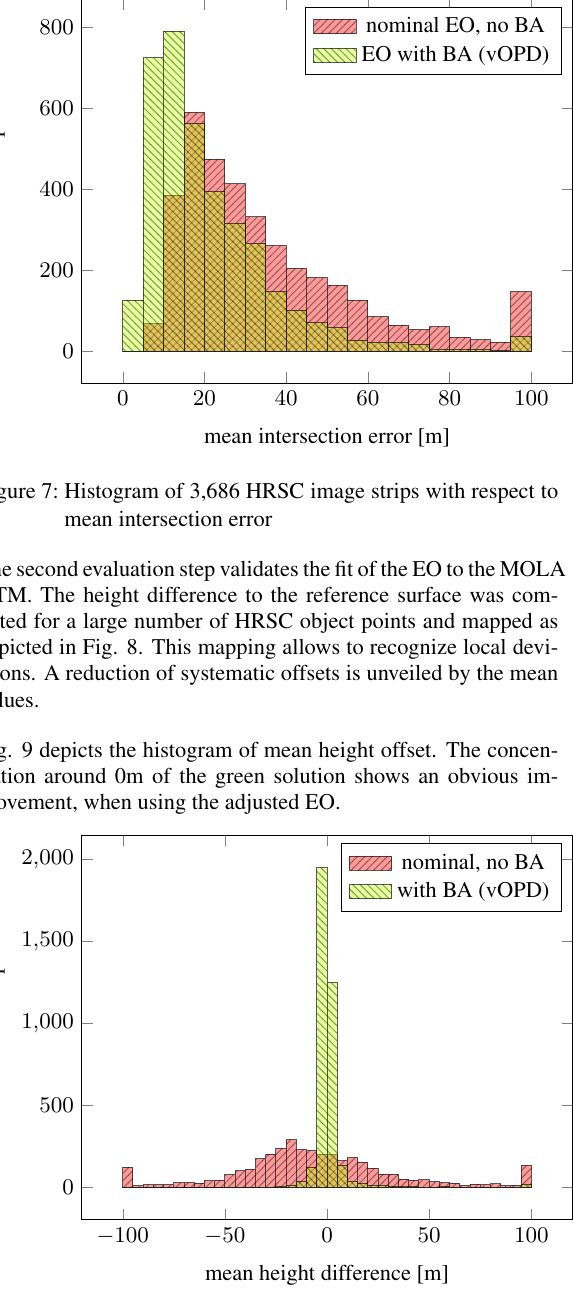
Figure 9: Histogram of 3,686 HRSC image strips with respect to mean MOLA height offset